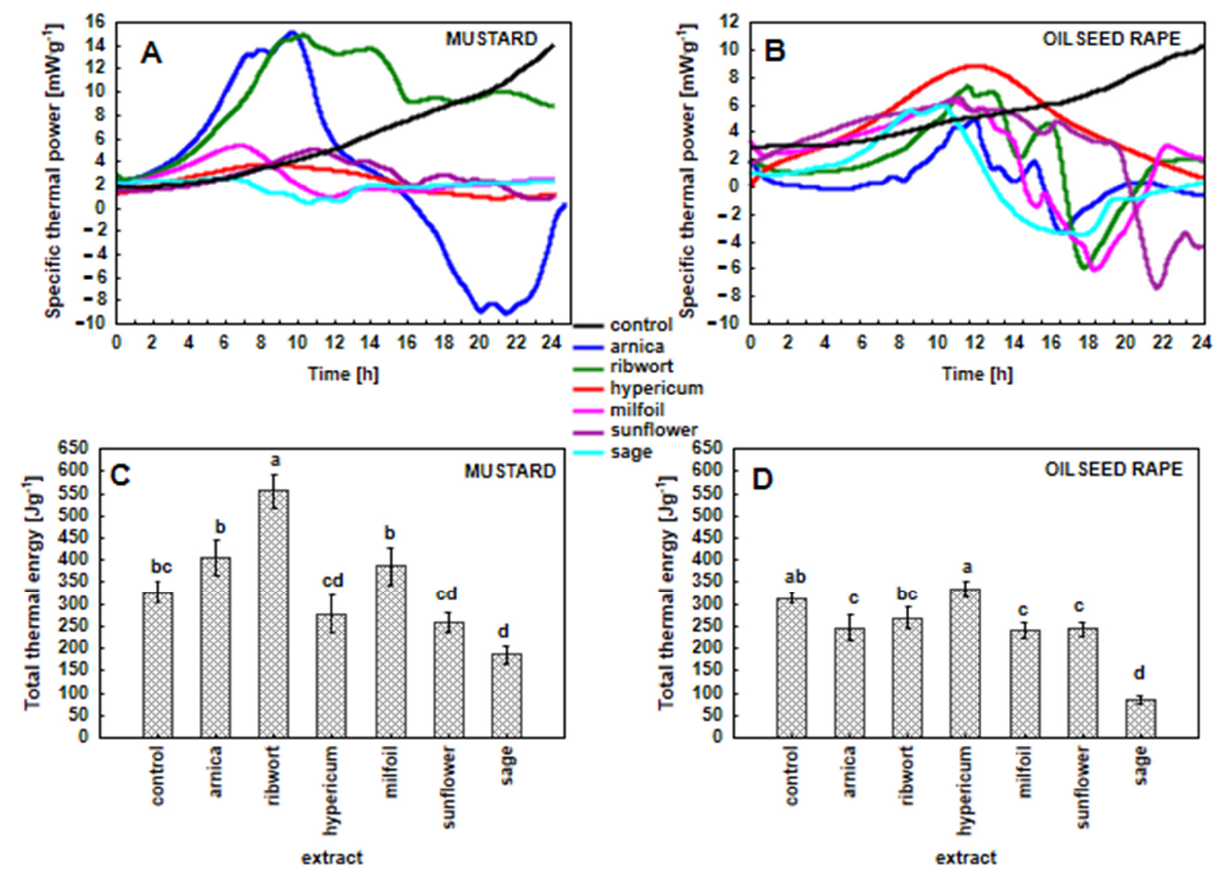
Figure 6. The specific thermal power curves of the white mustard ( A ) and oilseed rape ( B ) seedlings that were growing on the extracts from arnica (blue line), ribwort (green line), hypericum (red line), milfoil (pink line), sunflower (violet line), sage (light blue line) and water (control) (black line). The mean values were based on ten repetitions. The total heat that was emitted by the white mustard ( C ) and oilseed rape ( D ) seedlings that were growing on the extracts from arnica, ribwort, hypericum, milfoil, sunflower, sage and water (control). Mean values ± SD indicated by the same letters did not differ significantly at p ≤ 0.05 according to Duncan’s test (within the tested species), n = 10.